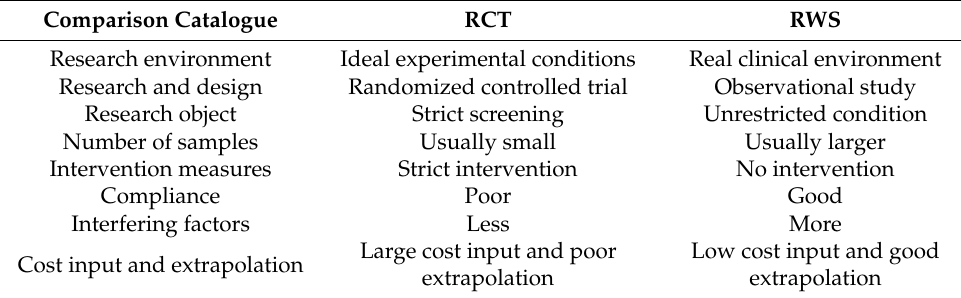
Table 1. Comparison between RWS and